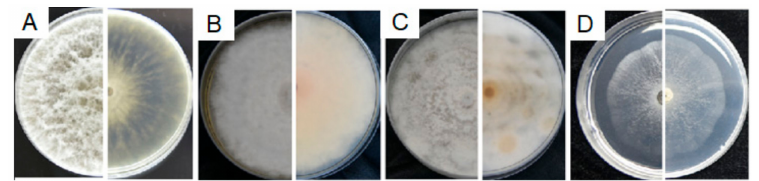
Figure 5. Conidial morphology of Neofusicoccum parvum isolate F7. ( A – D ) The front and back of the colony morphology on PDA, MEA, OA and WA plate.